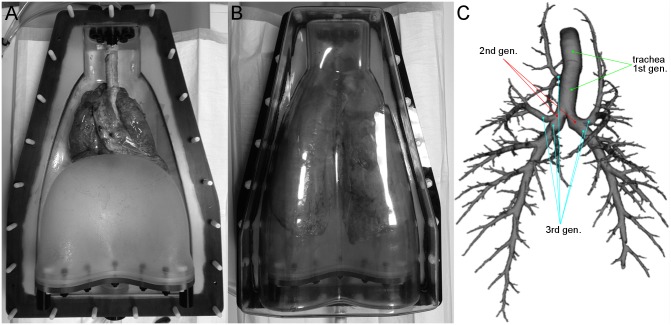
Porcine heart-lung-explant (A) was inflated with room air in an artificial shell (B). Continuous negative pressure was held up to mimic artificial pleural space. After MDCT, Data were sent directly to the post-processing server. The result of airway segmentation is shown as a three-dimensional volume reconstruction. The trachea is assigned to generation 1, right and left main bronchi are assigned to generation 2, tracheal bronchus starts at generation 3. That means we count 1 airway at generation 1, 2 at generation 2, 5 at generation 3, 10 at generation 4, and further 5*2^(i-3) airways for generation i, i>2 (C).